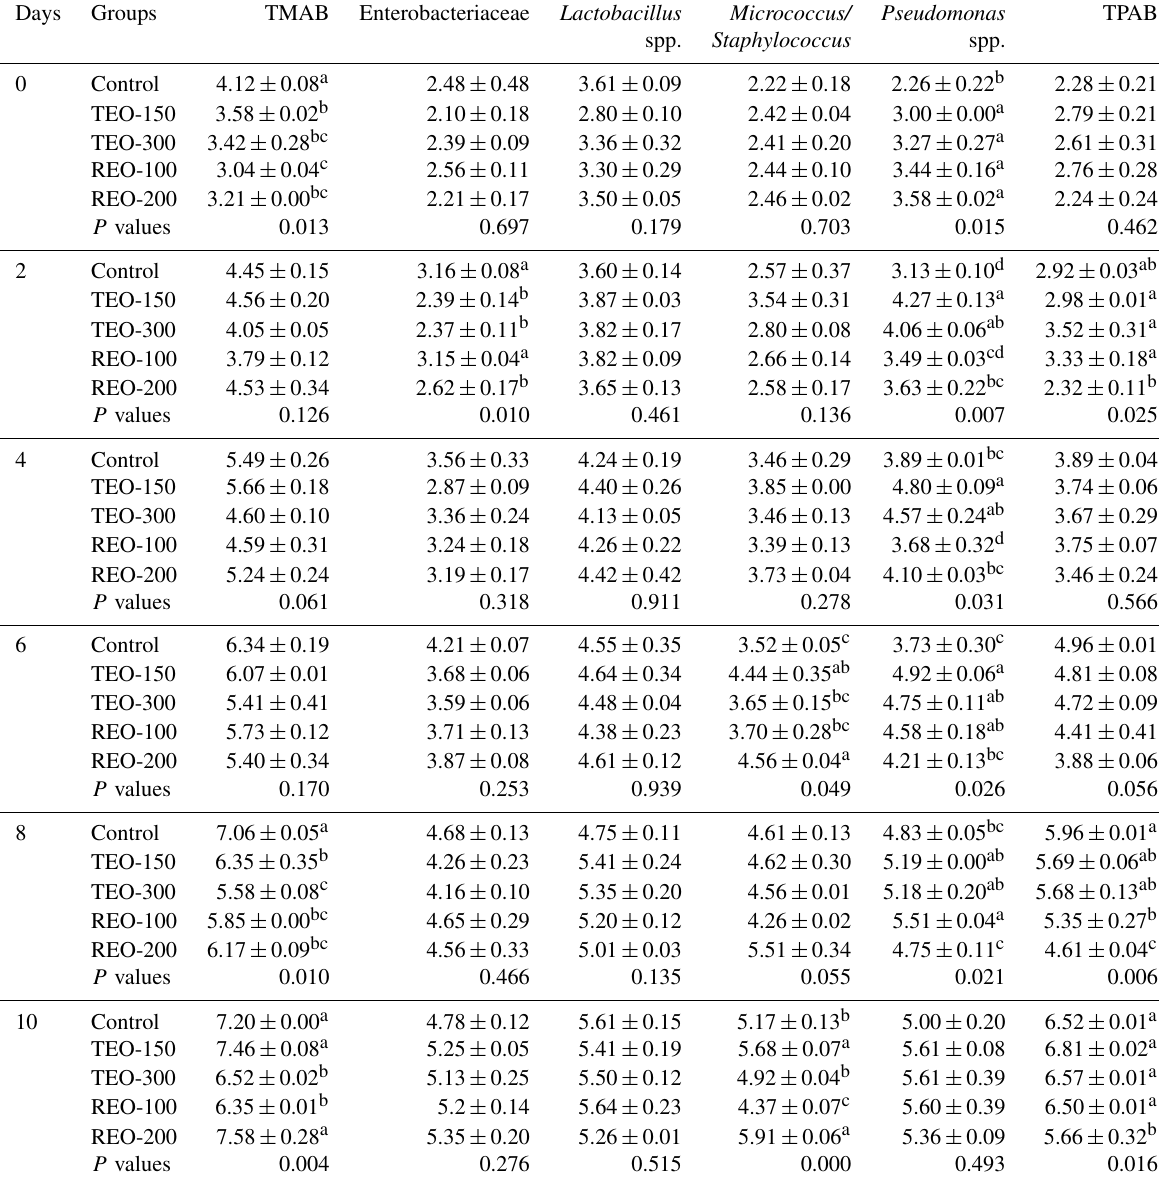
Table 3. Effects of dietary thyme and rosemary essential oils supplementation and storage time on TMAB, Enterobacteriaceae, Lactobacillus spp., Micrococcus/Staphylococcus spp., Pseudomonas spp. and TPAB counts in chicken breast meat (logcfug − 1